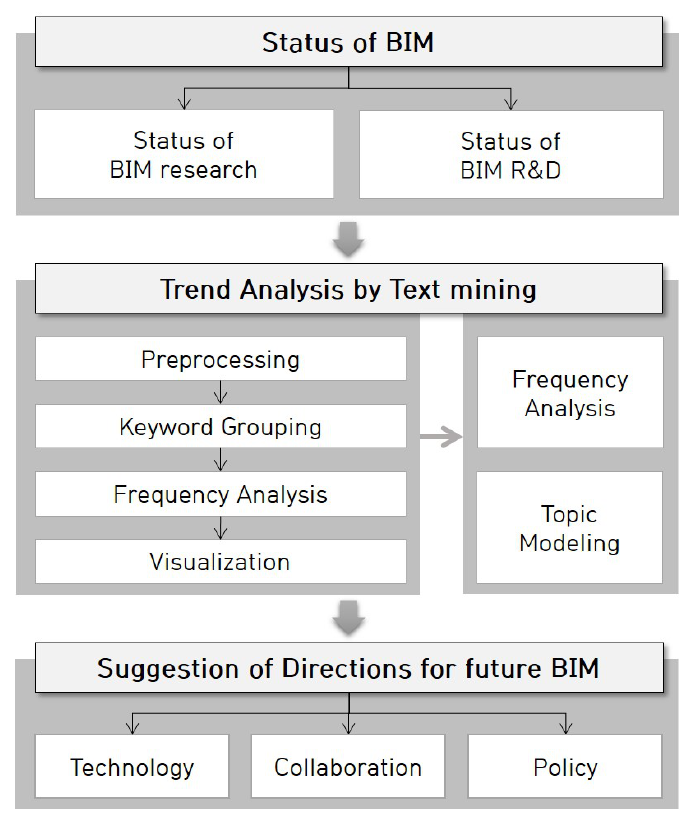
Figure 1. Research flow chart.